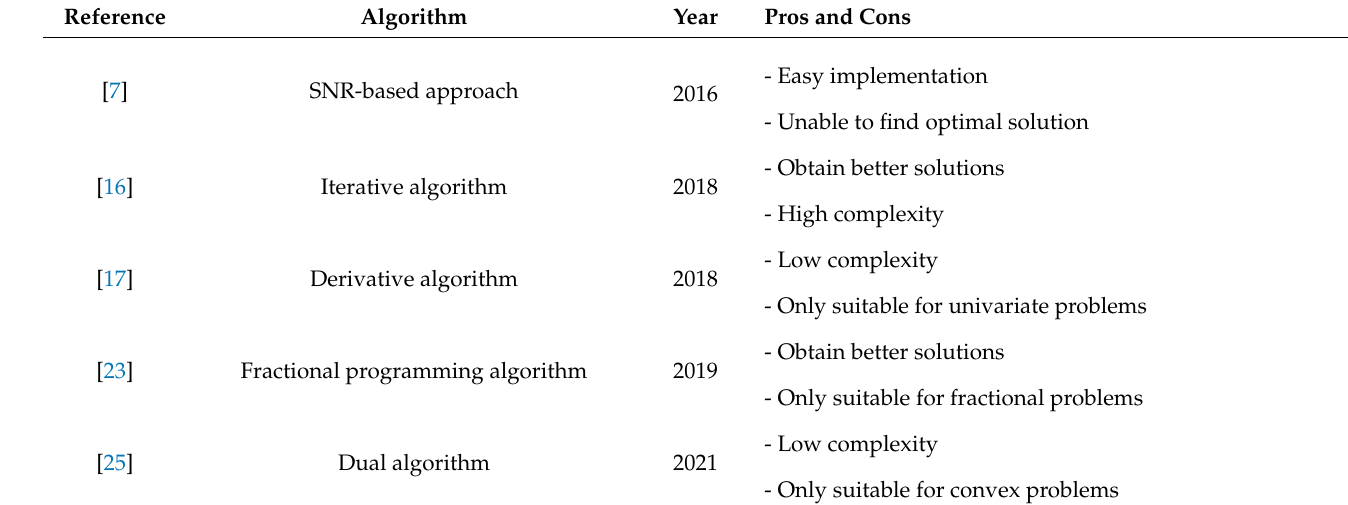
Table 1. A summary of related